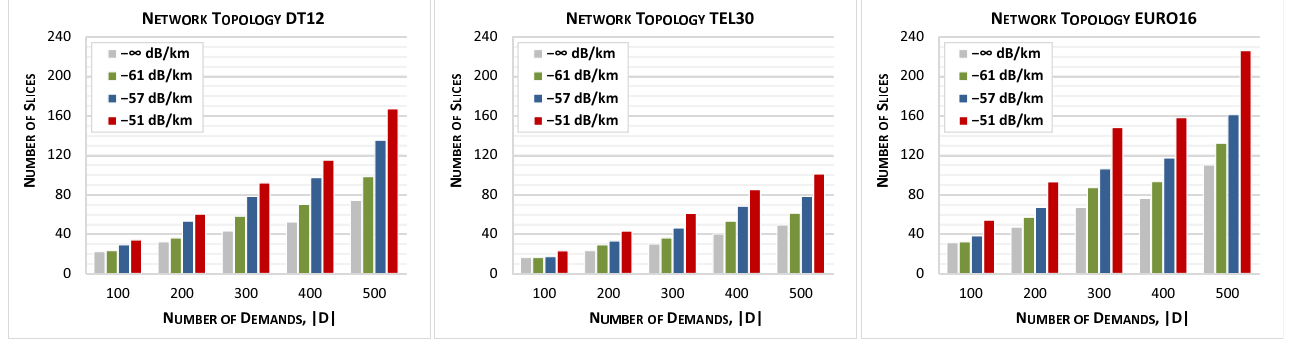
Figure 4. The required number of slices in a function of the number of demands in different network and crosstalk scenarios assuming fiber